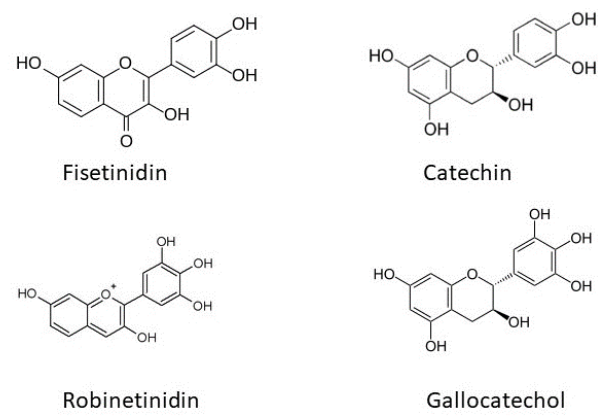
Figure 10. Mimosa tannin extract base units [81]. Table 8. Mechanical properties of plywood [81].